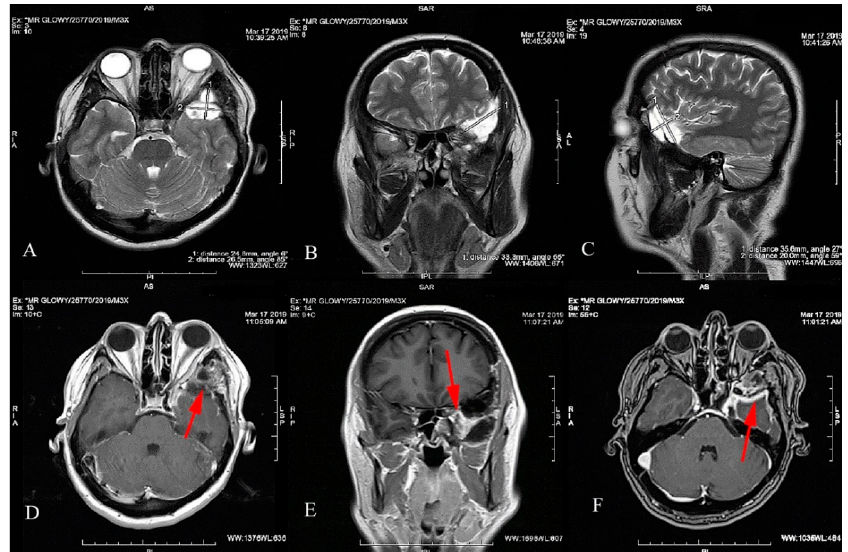
Figure 3. Postoperative MRI T2-weighted images with the SOM resection focus measuring 33.3 × 20 × 35.6 mm ( A – C ). The residual mass of the tumor shown in the T1-weighted images ( D – F ). The residue compresses the left temporal pole and is enhanced after gadolinium administration. The location of the tumor residue is marked with a red arrow.